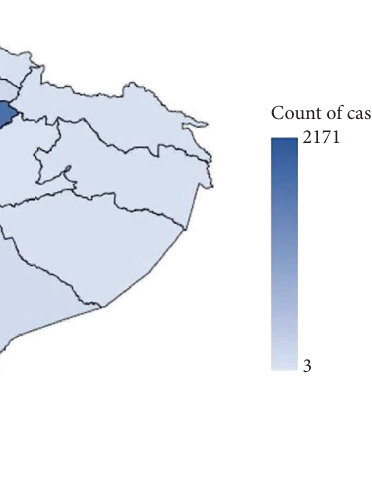
Figure 1: Number of cases of STS (STS: soft-tissue